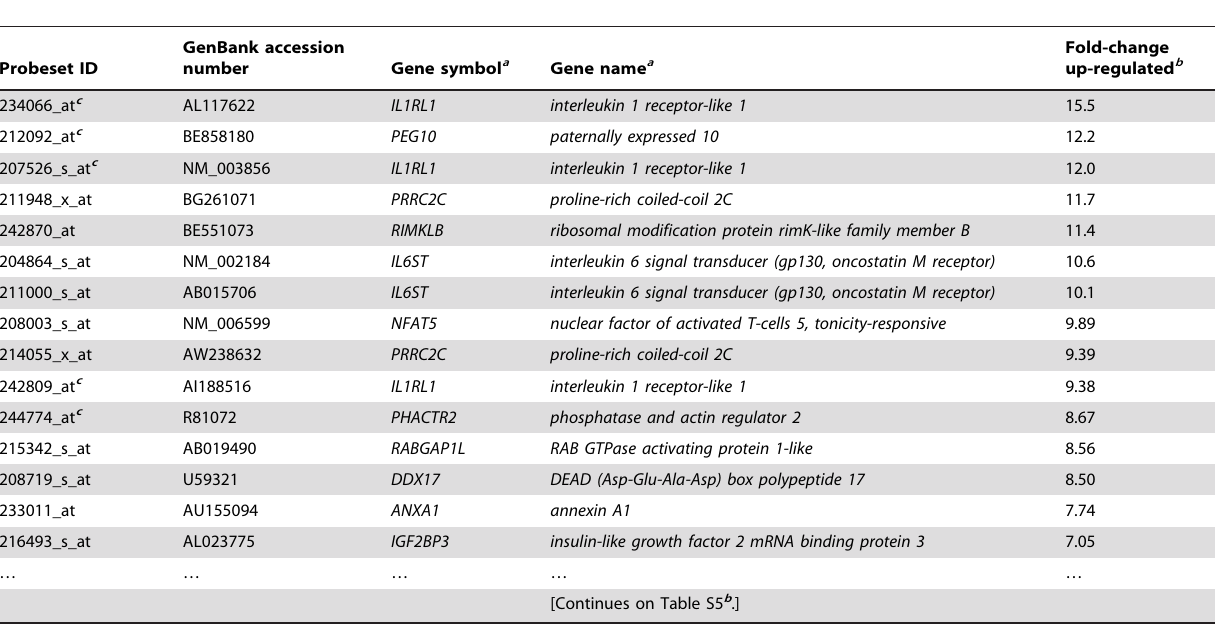
Table 3. RNA transcripts that were up-regulated in the SPB placentas, relative to the STB placentas, according to the microarray experiment (Mann-Whitney test, adjusted by the Benjamini and Hochberg method, adjusted p , 0.05).